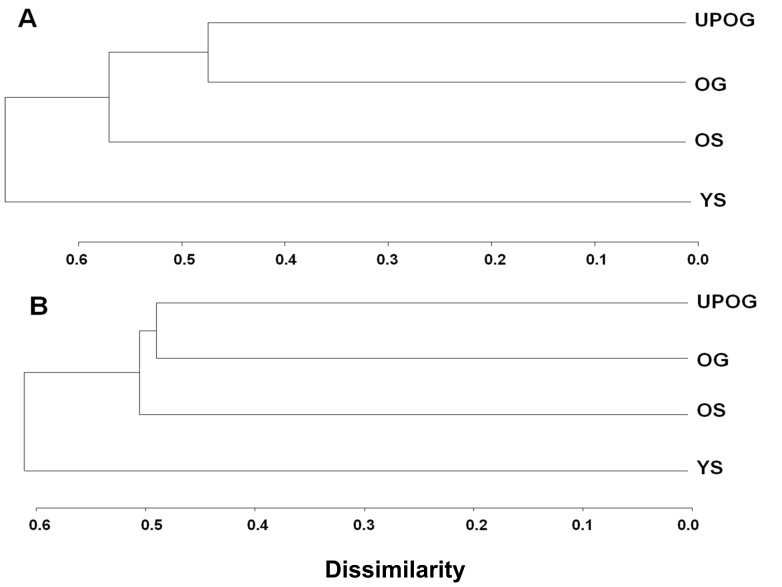
Phylogenetic dissimilarity of the plant communities based on overstorey (A) and understory (B) data from all plots per forest type (UPGMA clustering of the Unifrac distance matrix).YS represents young secondary forest; OS represents old secondary forest; UPOG represents understorey planted old-growth forest (the old-growth forests with Amomum villosum plantation in the understorey); OG represents old-growth forest.